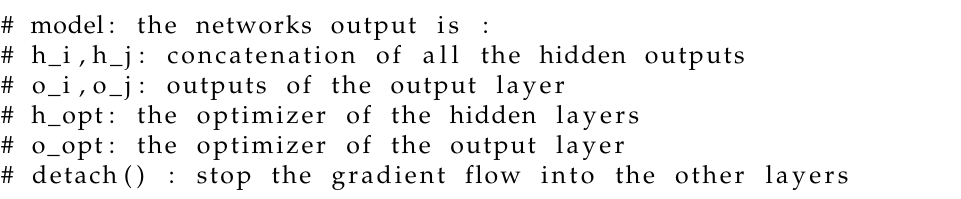
Algorithm 1 Pseudocode of LAC in a Pytorch-like